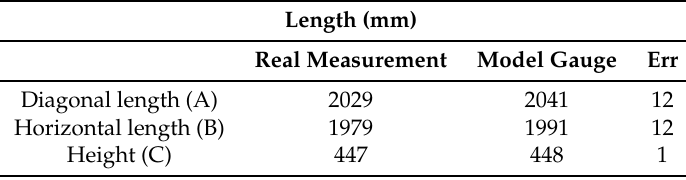
Table 3. Comparison between the CAD model and real excavator in measured length.